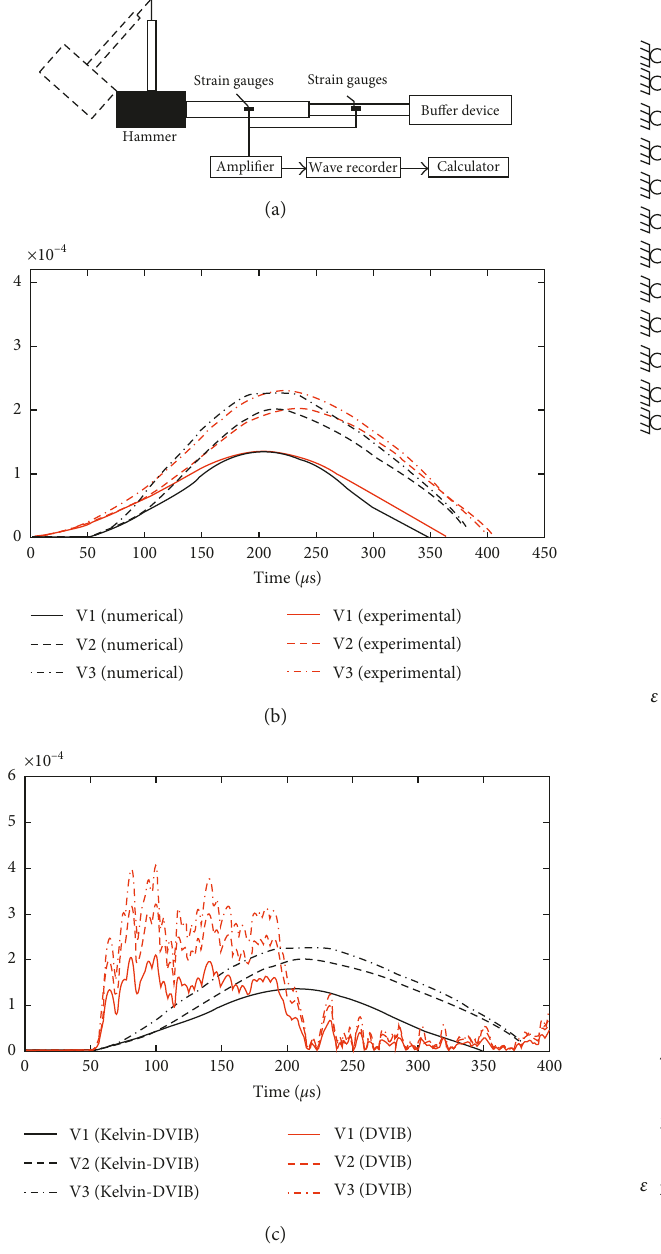
Figure 5: Simulation of the long-bar impact test: (a) test system after Niu and Zhu [26]; (b) comparison between the simulated and tested strain in [26]; (c) comparison of the simulation results with and without viscosity.